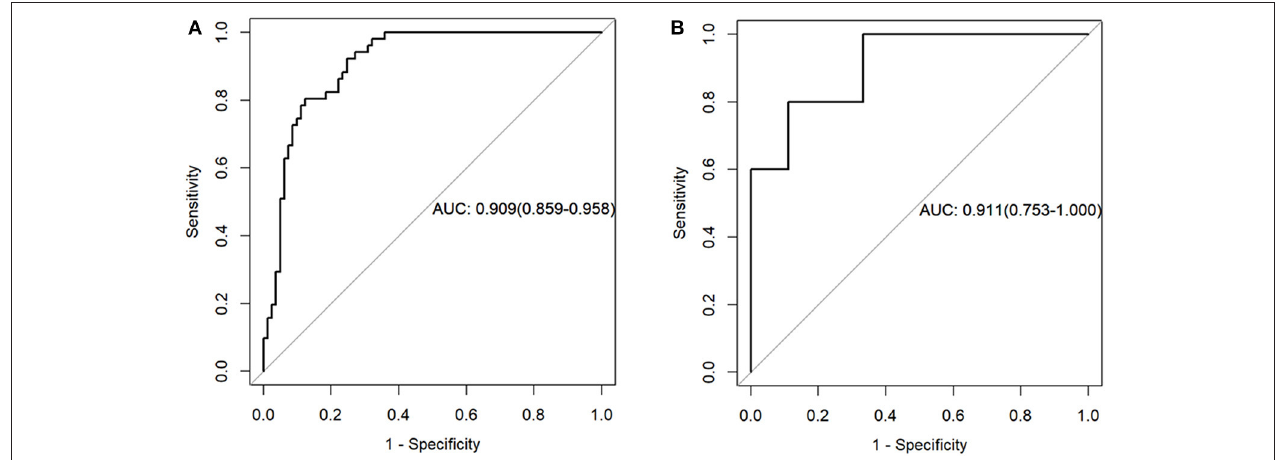
FIGURE 2 | Receiver operating characteristic curves of the radiomics model in the training (A) and validation sets (B)